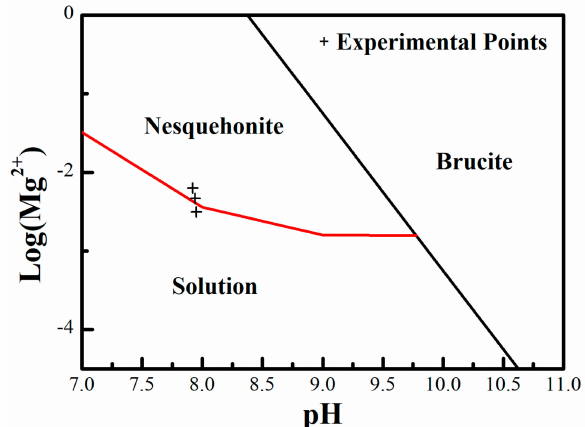
Figure 1. Stability diagram of brucite and nesquehonite with respect to Mg 2 + activity and solution pH. The cross symbols mark the compositions of experimental solutions in this